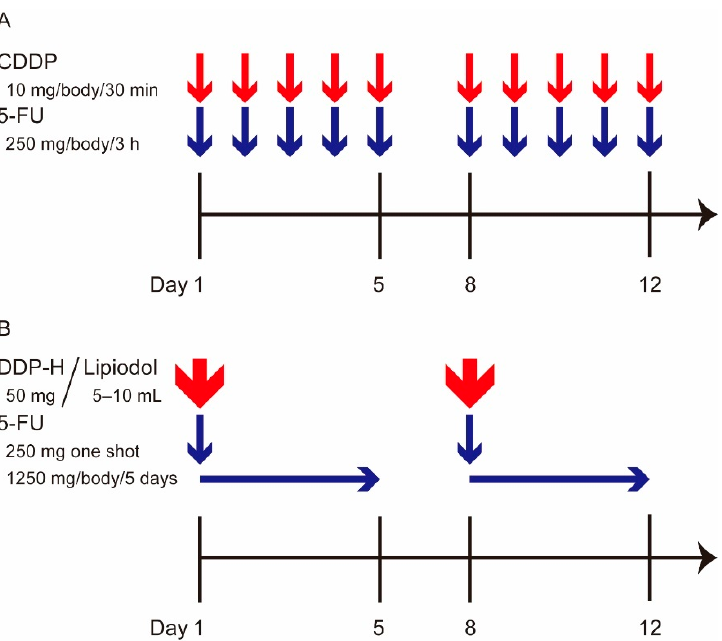
Figure 1. LFP and New FP for inpatient treatment regimens. ( A ) The LFP regimen. As an inpatient regimen, one course consisted of the daily administration of 10 mg of CDDP for 30 min from day 1 to day 5, followed by 250 mg of 5-FU continuously injected for 3 h from day 1 to day 5. Day 6 and 7 was the rest period. In principle, this weekly regimen was repeated 2 or 3 times as one cycle of LFP. ( B ) The New FP regimen. The fine-powder formulation of CDDP (DPP-H) was used in New FP regimen. The inpatient regimen comprised 50 mg of fine-powder DPP-H suspended in 5–10 mL of lipiodol, the amount of which was determined by the tumor volume. At day 1, the DPP-H-lipiodol suspension was injected from the implanted catheter under the angiography, followed by injection of 250 mg of 5-FU. Next, 1250 mg of 5-FU was continuously injected using an infusion balloon pump. This regimen was applied once a week during the first two weeks. LFP: Low dose CDDP plus 5-FU, CDDP: cisplatin, 5-FU: 5-fluorouracil.